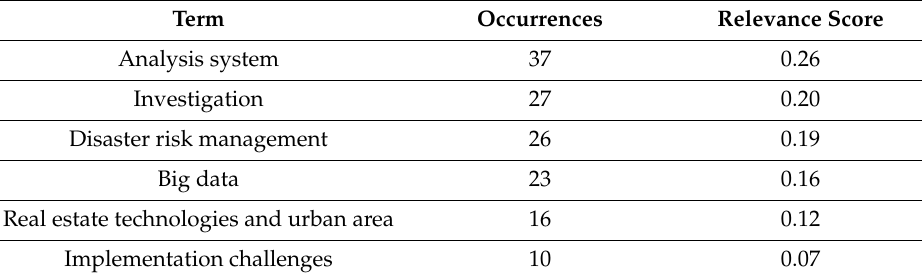
Table 3. Most repeated keywords in the big data papers from 2010 – 2020.